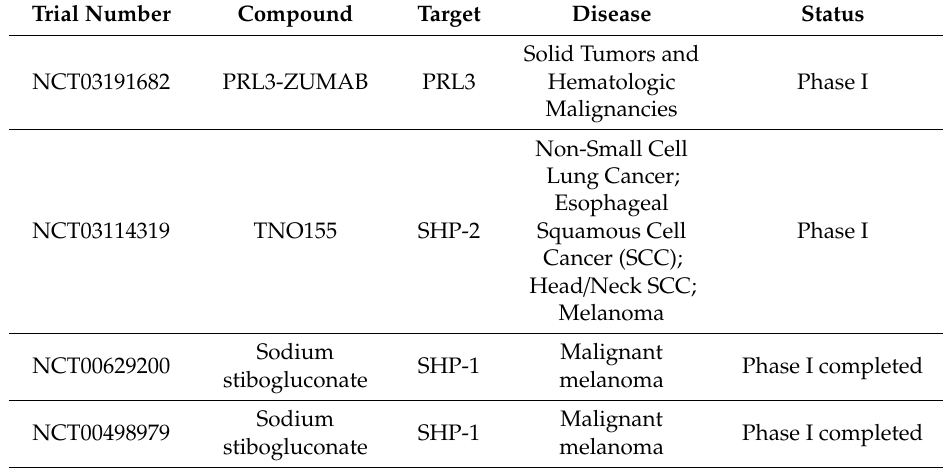
Table 1. Protein tyrosine phosphatase (PTP) inhibitors involved in clinical trials for melanoma treatment. Trial Number Compound Target Disease Status Solid Tumors and NCT03191682 PRL3-ZUMAB PRL3 Hematologic Phase I Malignancies Non-Small Cell Lung Cancer; Esophageal Phase I Squamous Cell NCT03114319 TNO155 SHP-2 Cancer (SCC); Head / Neck SCC; Melanoma Malignant Sodium Phase I completed SHP-1 NCT00629200 melanoma stibogluconate Sodium Malignant NCT00498979 SHP-1 Phase I stibogluconate melanoma